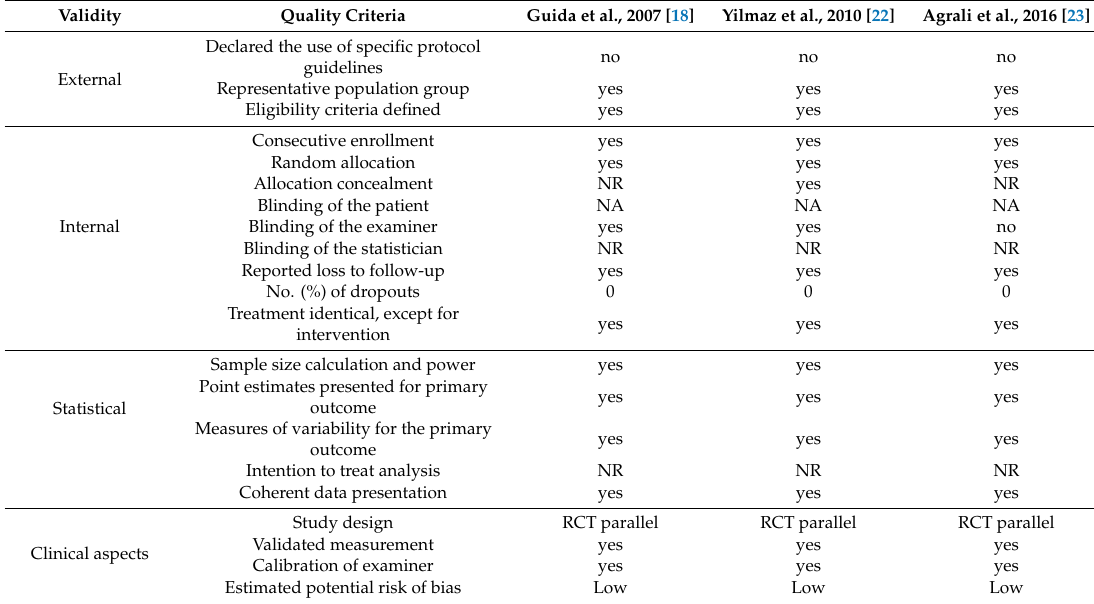
Table 4. Quality assessment of the included